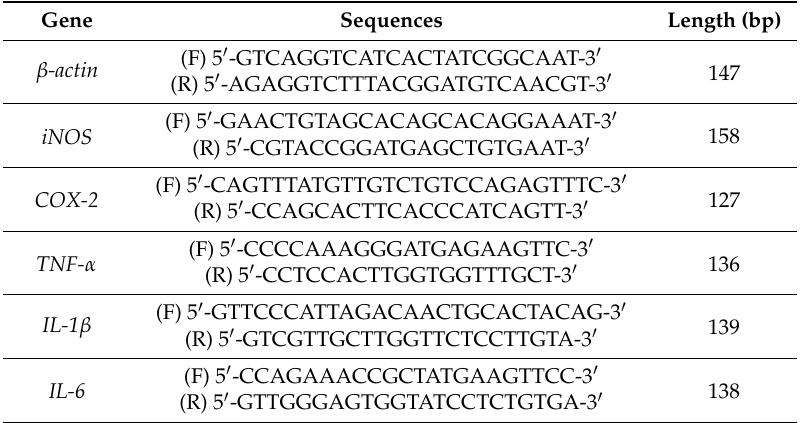
Table 1. Primers of mice for real-time